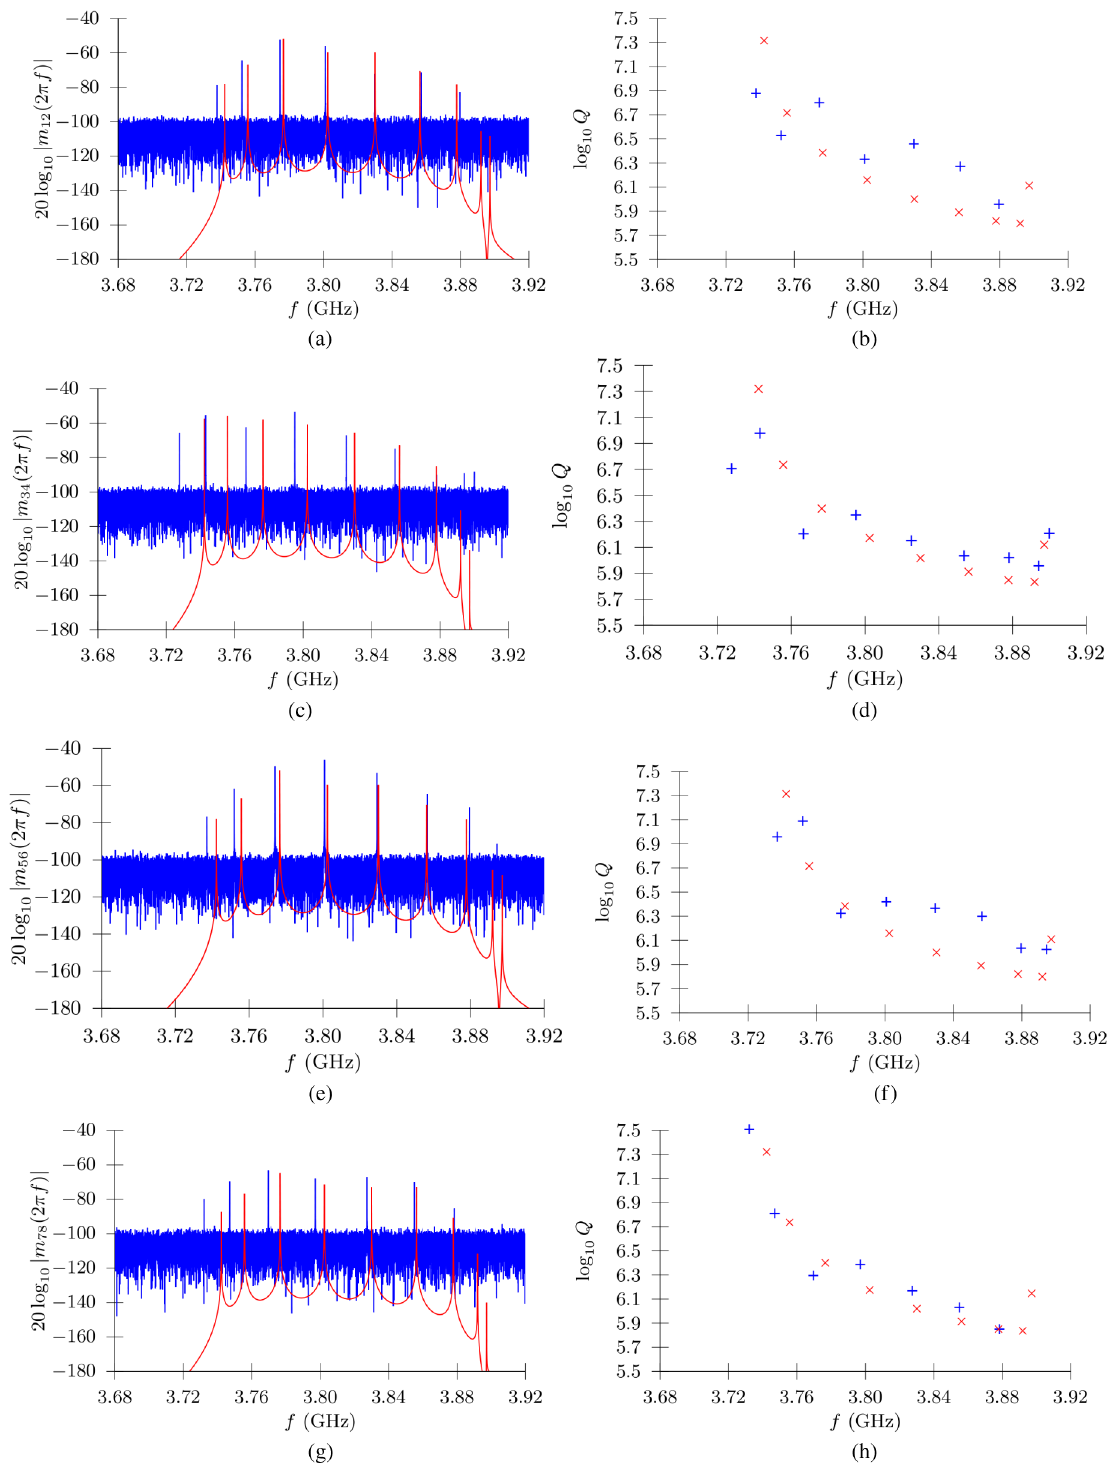
FIG. 12. Magnification of the transmission spectra corresponding to the fundamental TM bands of all four cavities in the ACC39 string (left-hand side) and the resulting quality factors of the peaks computed by means of [27] (right-hand side). Blue curves and blue plusses represent measured data, whereas red curves and red crosses show the data obtained by simulation. The indices of the scattering parameters m (see ordinate labeling) refer to the port nomenclature presented jk in Fig.